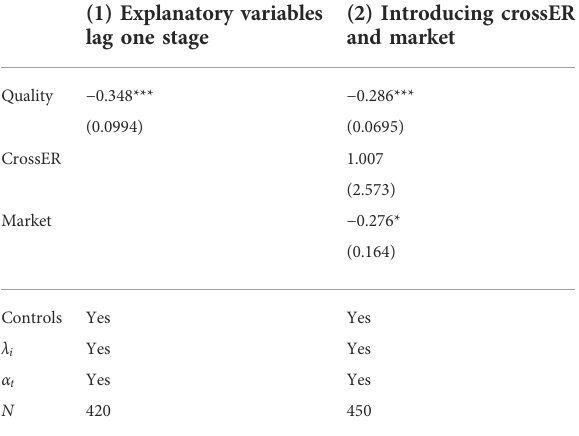
TABLE 2 Robustness test results of model